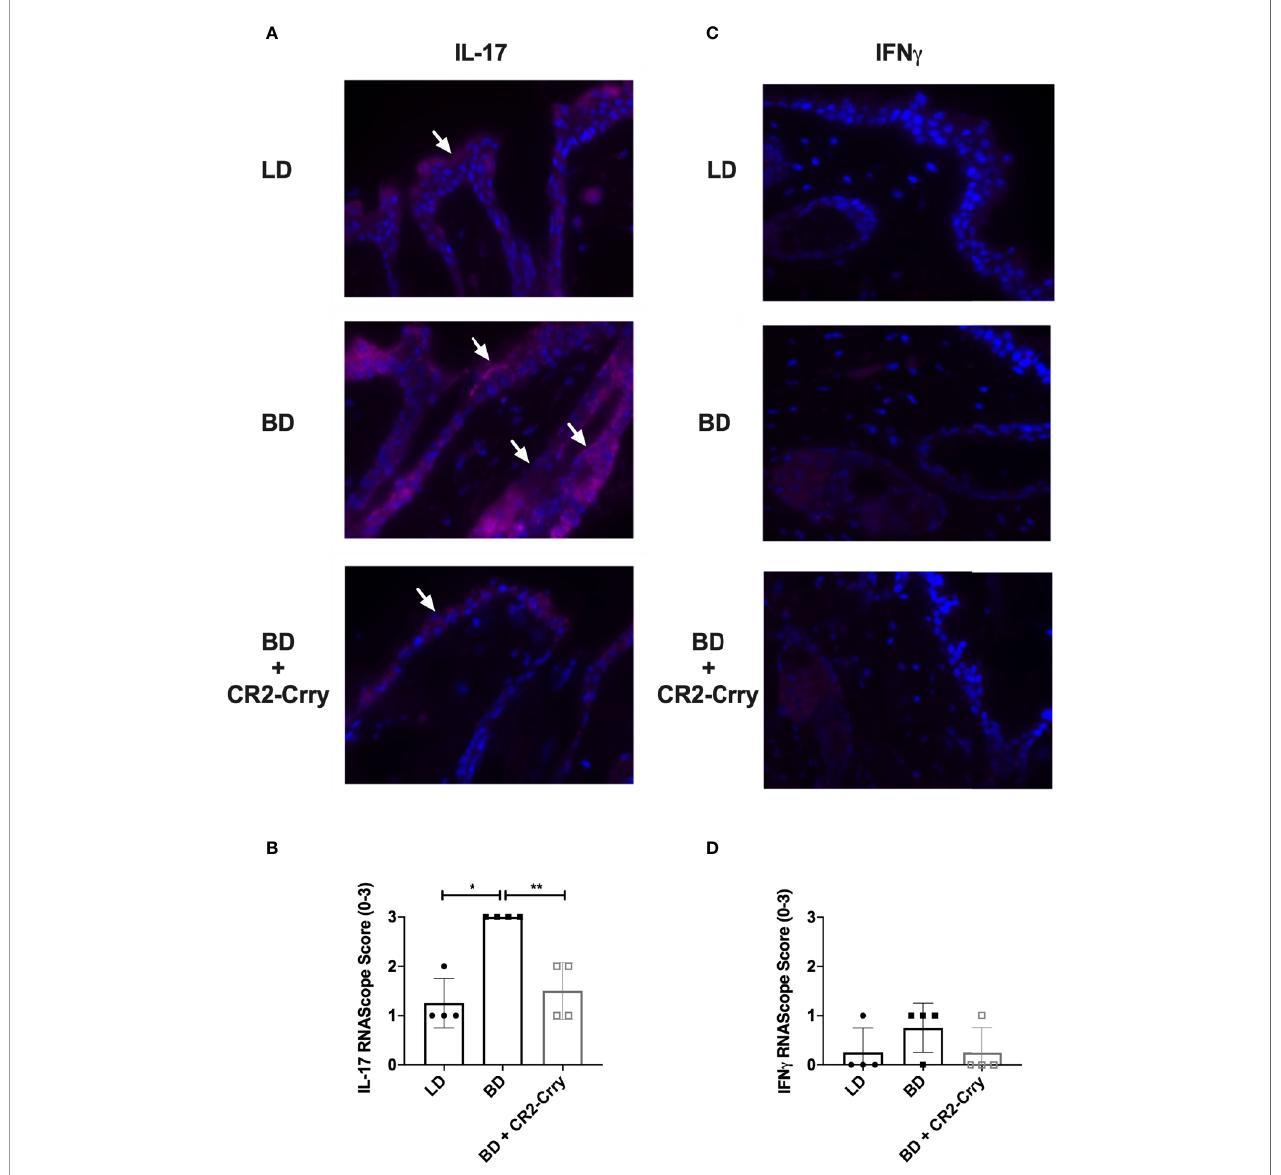
FIGURE 6 | CR2-Crry donor therapy reduces intragraft IL-17 mRNA expression. Representative images from n = 4/group of IL-17 and IFN g RNAScope in-situ hybridization (A, C) . Positive mRNA signal (red) for IL-17 was seen in the squamous epithelim of all groups (A) , but was quantitatively increased in recipients of brain dead donor grafts (B) . No signi fi cant mRNA for IFN g was noted in the epithelium or immune cells in any group (C, D) . Images x60 magni fi cation, n = 4 all groups. Pairwise comparison for IL-17 between LD vs BD (*p < 0.03), and BD vs BD+CR2-Crry (**p < 0.04); differences between LD vs BD+CR2-Crry were not signi fi cantly